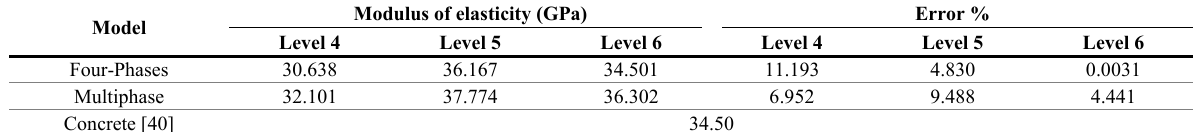
Table 8. Numerical results by homogenization steps.